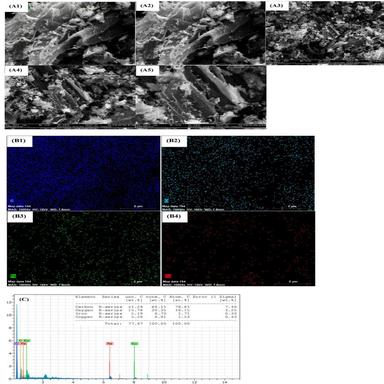
EDX image (A1), mapping image (A2) and SEM images of FLPWAC composite (A3-A5) at different expansion ratios, (B) elemental mapping of FLPWAC composite for C (B1), O (B2), Fe (B3), and Cu (B4), and (C) corresponding EDX elemental contents.